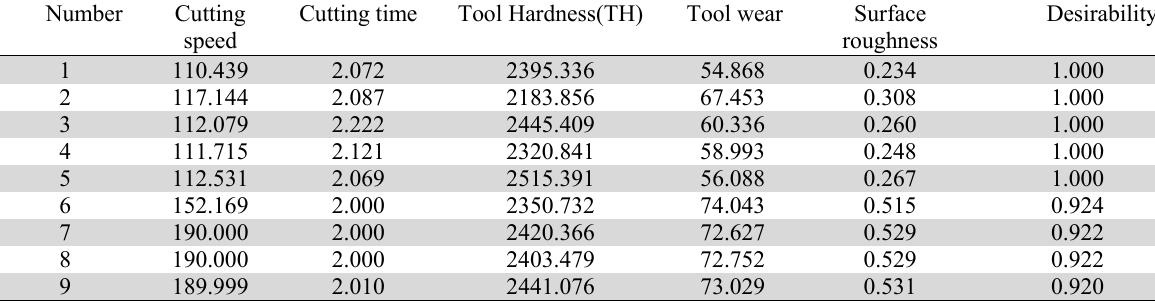
Response optimizations for tool wear and surface roughness